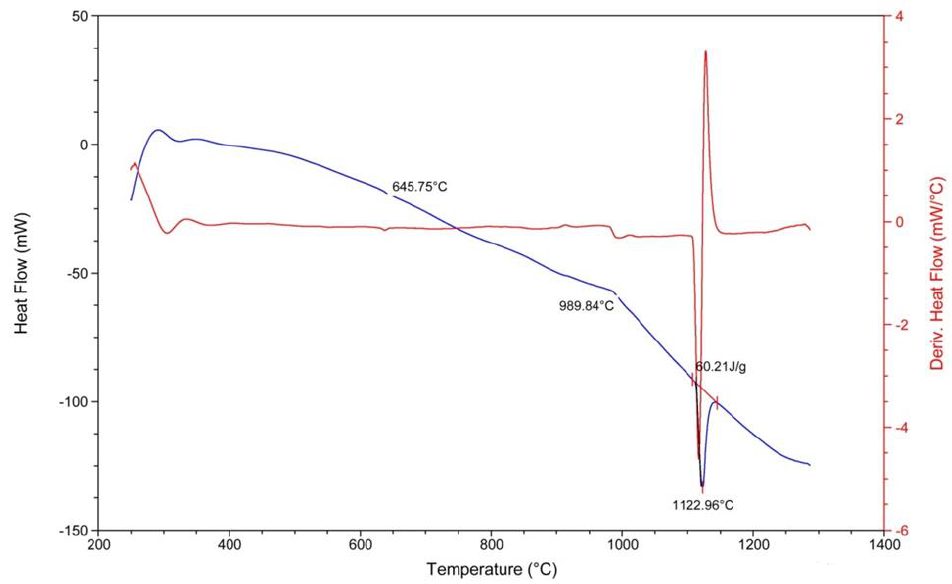
Figure 11. DSC of intermetallic compounds Al 3 Er curves. The temperature of 645.75 ◦ C corresponds to the isothermal line of the eutectic reac- tion L → (Al) + (Al 3 Er), and the temperature of 989.84 ◦ C corresponds to the peretectic transformation Al 3 Er = Al 2 Er + Al. At a temperature of 1123 ◦ C, an endothermic effect corresponding to the liquidus point was